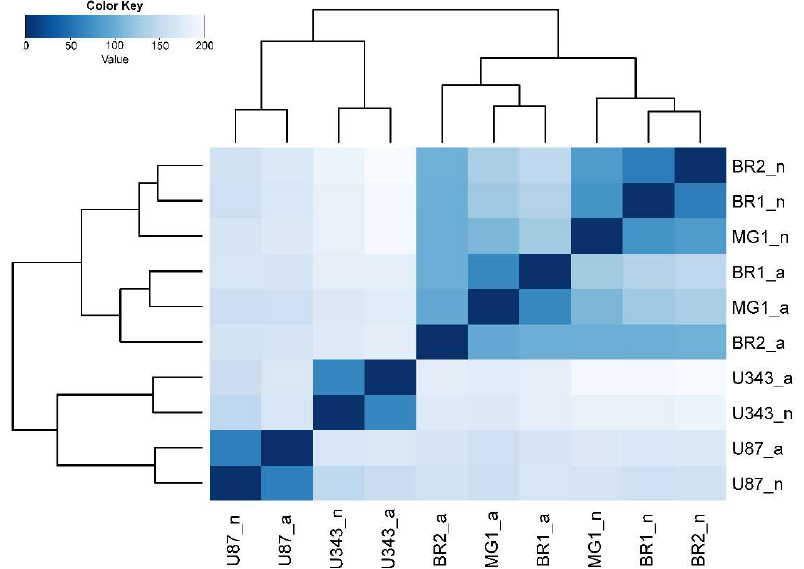
Figure 2. Heatmap and sample tree of Euclidean distances of RNAseq variance stabilizing trans- formed (VST) gene expression data of glioma cell cultures. The complete agglomeration method for clustering was used.